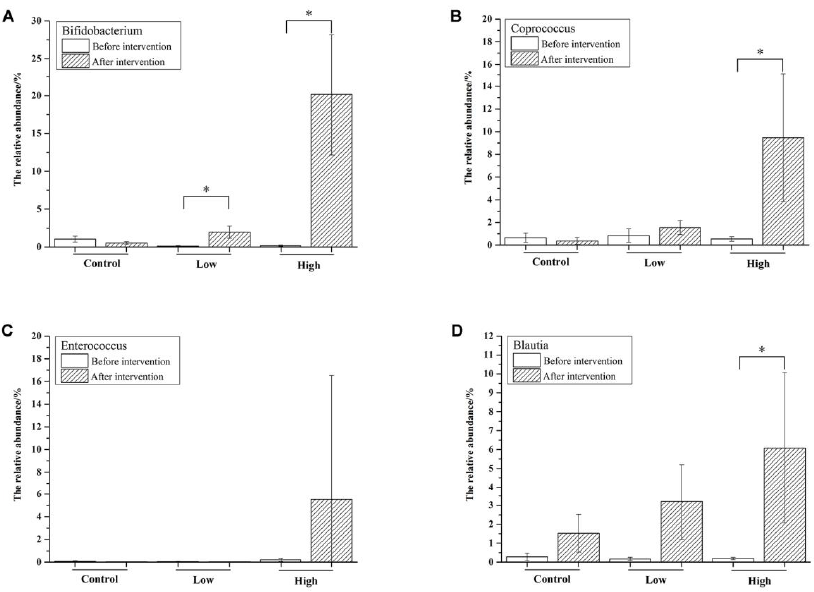
Figure 4. Changes of the relative abundance of selected genera, including Bifidobacterium ( A ), Coprococcus ( B ), Enterococcus ( C ), and Blautia ( D ). Significant differences ( p < 0.05) are indicated with the symbol (*).